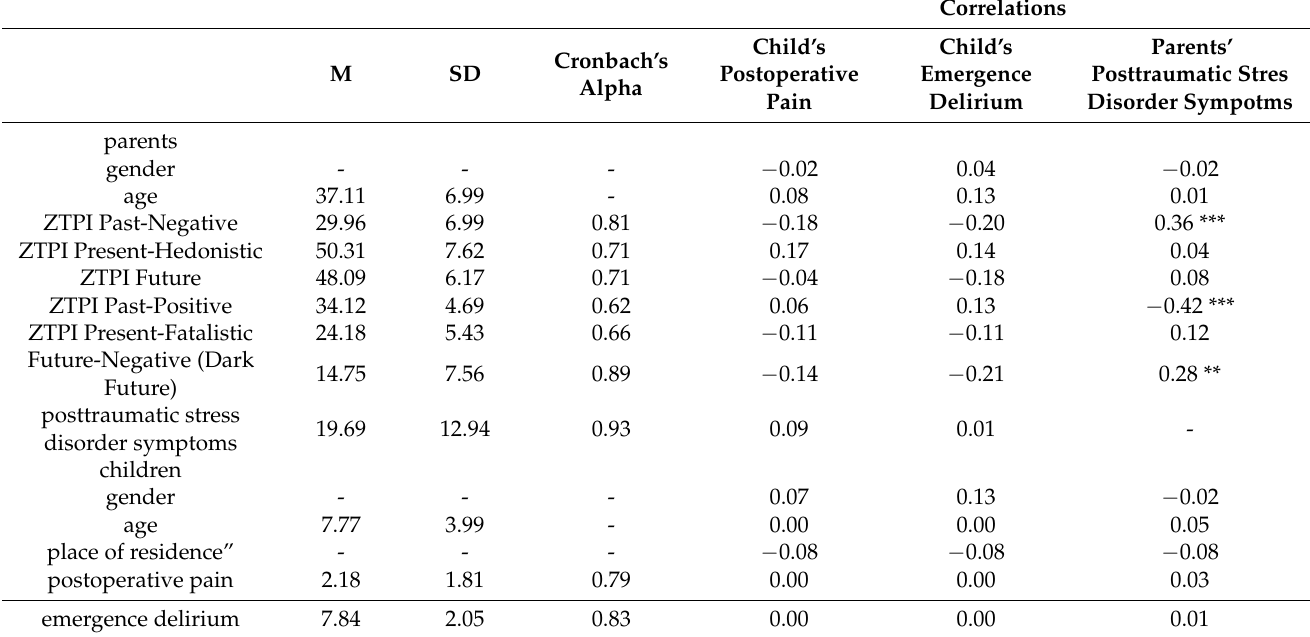
Table 1. Descriptive statistics of the parents’ time perspective and posttraumatic stress disorder symp- toms after surgery and correlations with child’s pain, emergence agitation and parents’ posttraumatic stress disorder symptoms.